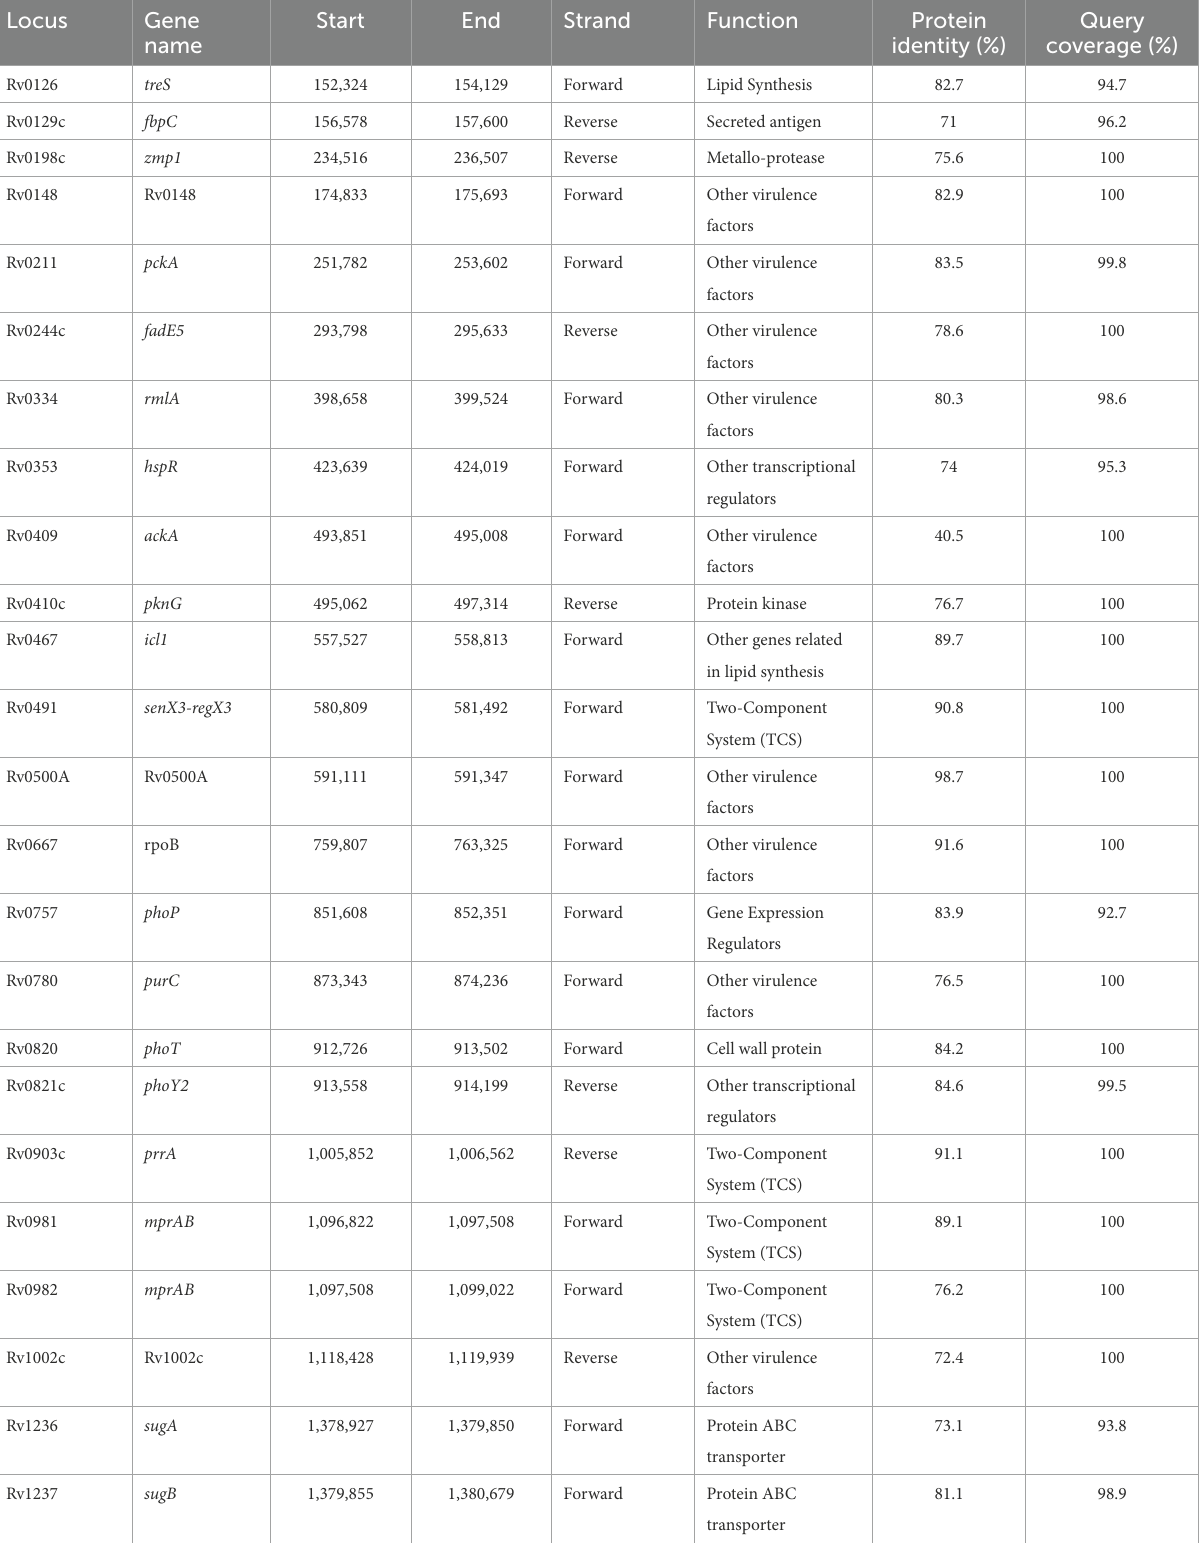
TABLE 2 M. tuberculosis virulence genes with high similarity in M . brumae .